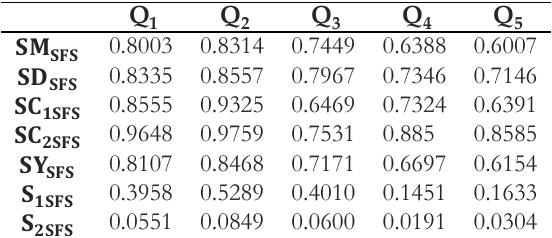
Table 3. Similarity values between patient and